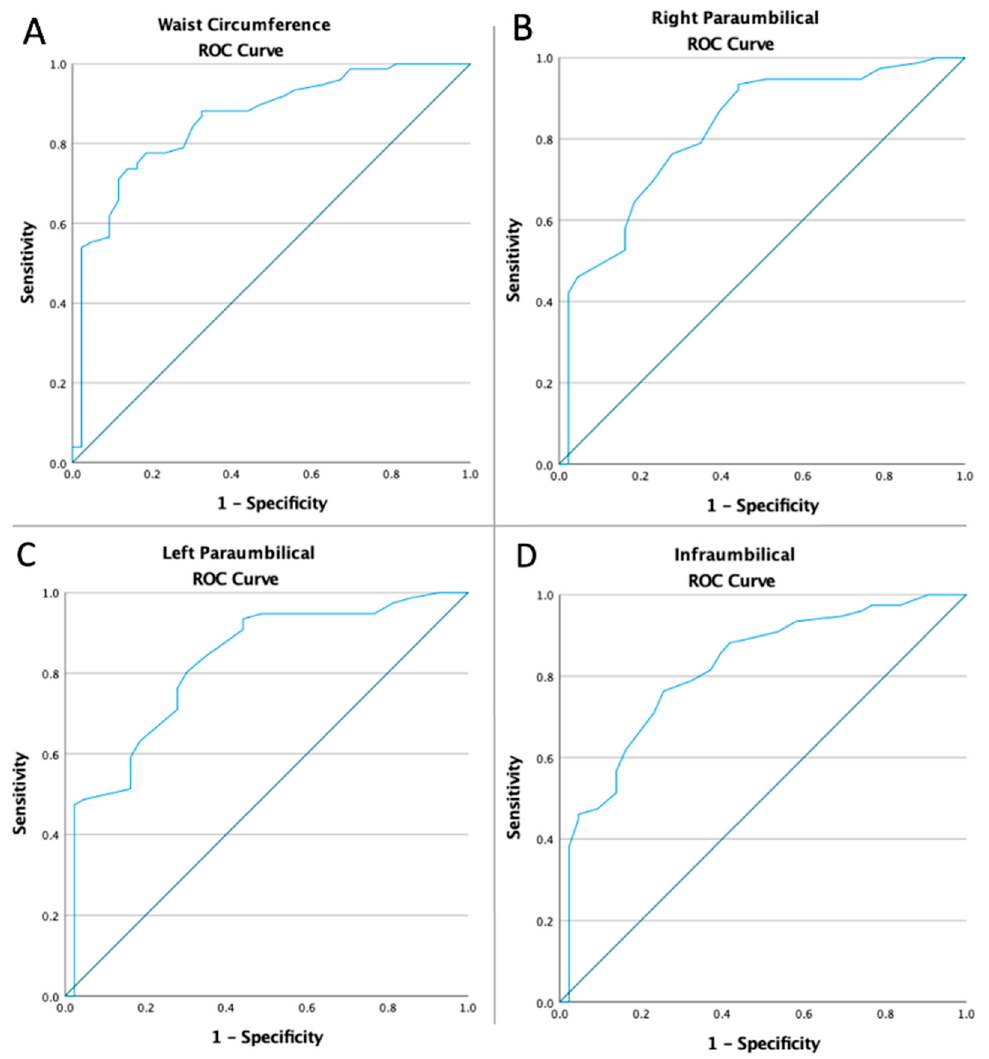
Figure 4. ROC Curve analyzed the NAFLD risk in terms of the abdominal anthropometric measurements ( A ): waist circumference (AUC: 0.859, p < 0.0001), ( B ): right paraumbilical (AUC: 0.819, p < 0.0001), ( C ): left paraumbilical (AUC: 0.821, p < 0.0001), and ( D ): infraumbilical (AUC: 0.816, p < 0.0001).